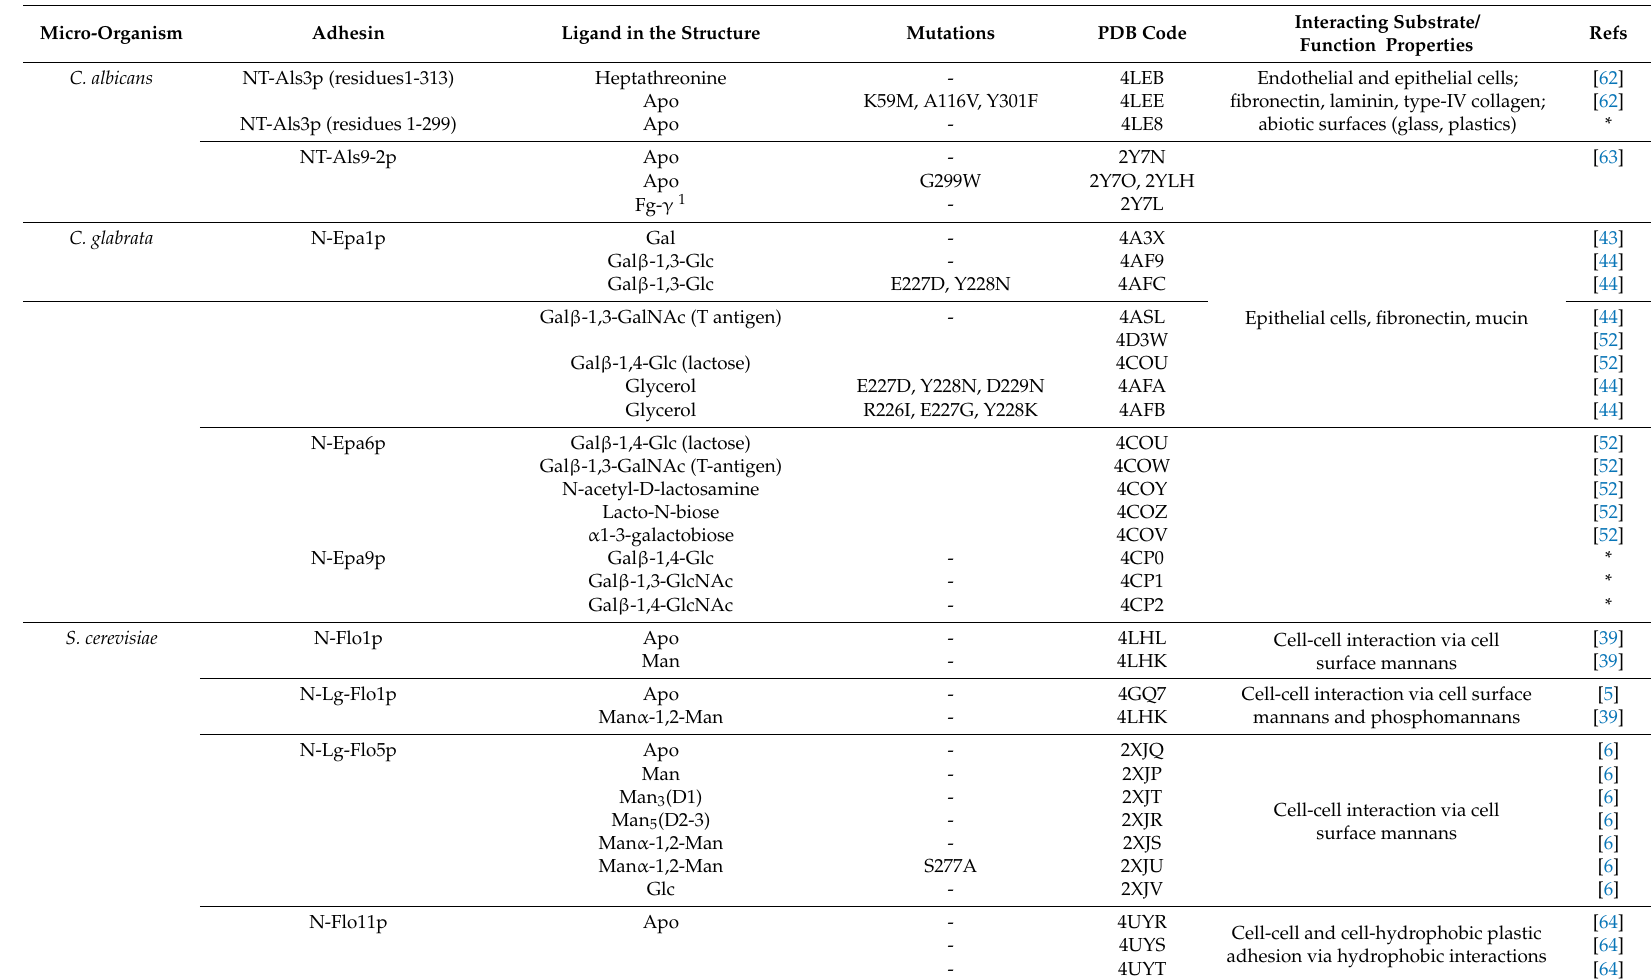
Table 1. Protein structures of yeast adhesins deposited in the Protein Data Bank (PDB,